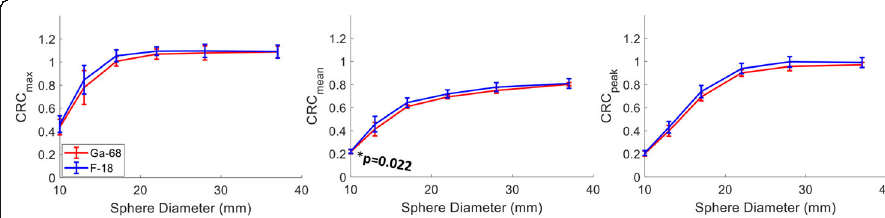
Fig. 7 Average CRC max (left), CRC mean (middle) and CRC peak (right) for all 6 Gallium-68 (blue curve) and the 12 Fluorine-18 (red curve) acquisitions. All Fluorine-18 acquisitions have been reconstructed with PSF 6.4/5 , and the Gallium-68 includes all PSF 6.4/5 and BPL 800 reconstructions. The error bars represent the standard deviation between sites. Significant difference was noticed for the 10-mm sphere at the 5% significance